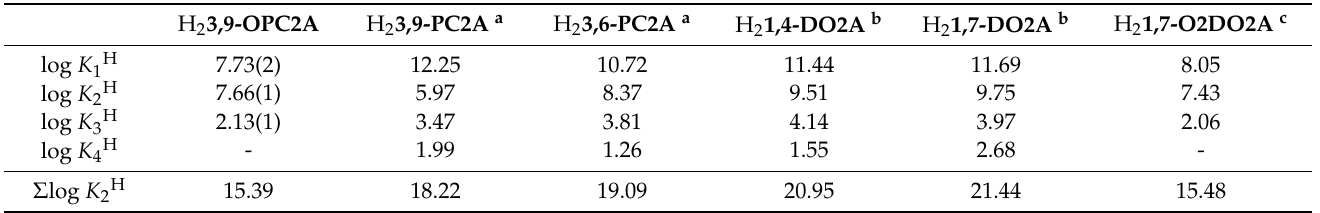
Table 2. Protonation constants of the H 2 3,9-OPC2A, H 2 3,9-PC2A, H 2 3,6-PC2A, H 2 1,4-DO2A, H 2 1,7- DO2A , and H 2 1,7-O2DO2A ligands (T = 25 ◦ C, I = 0.15 M NaCl; the values shown in parenthesis are the standard